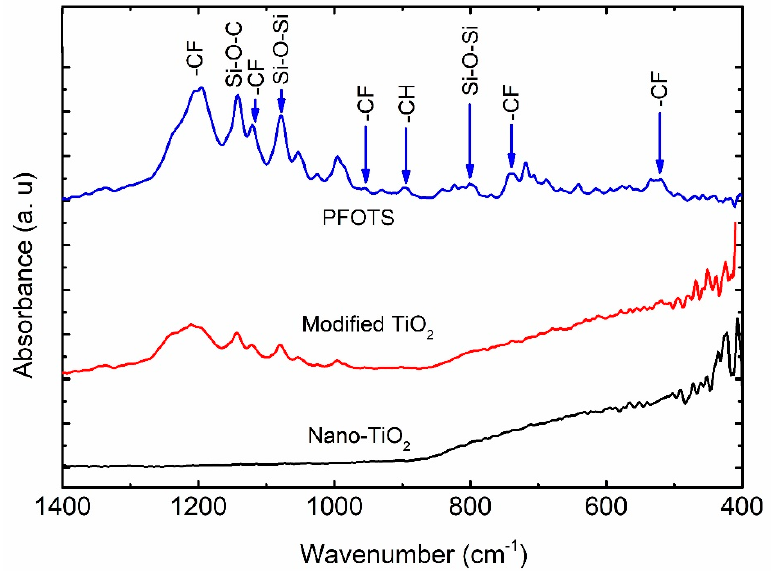
Figure 6. FT-IR spectra of the PFOTS modified nano-TiO 2 particles.